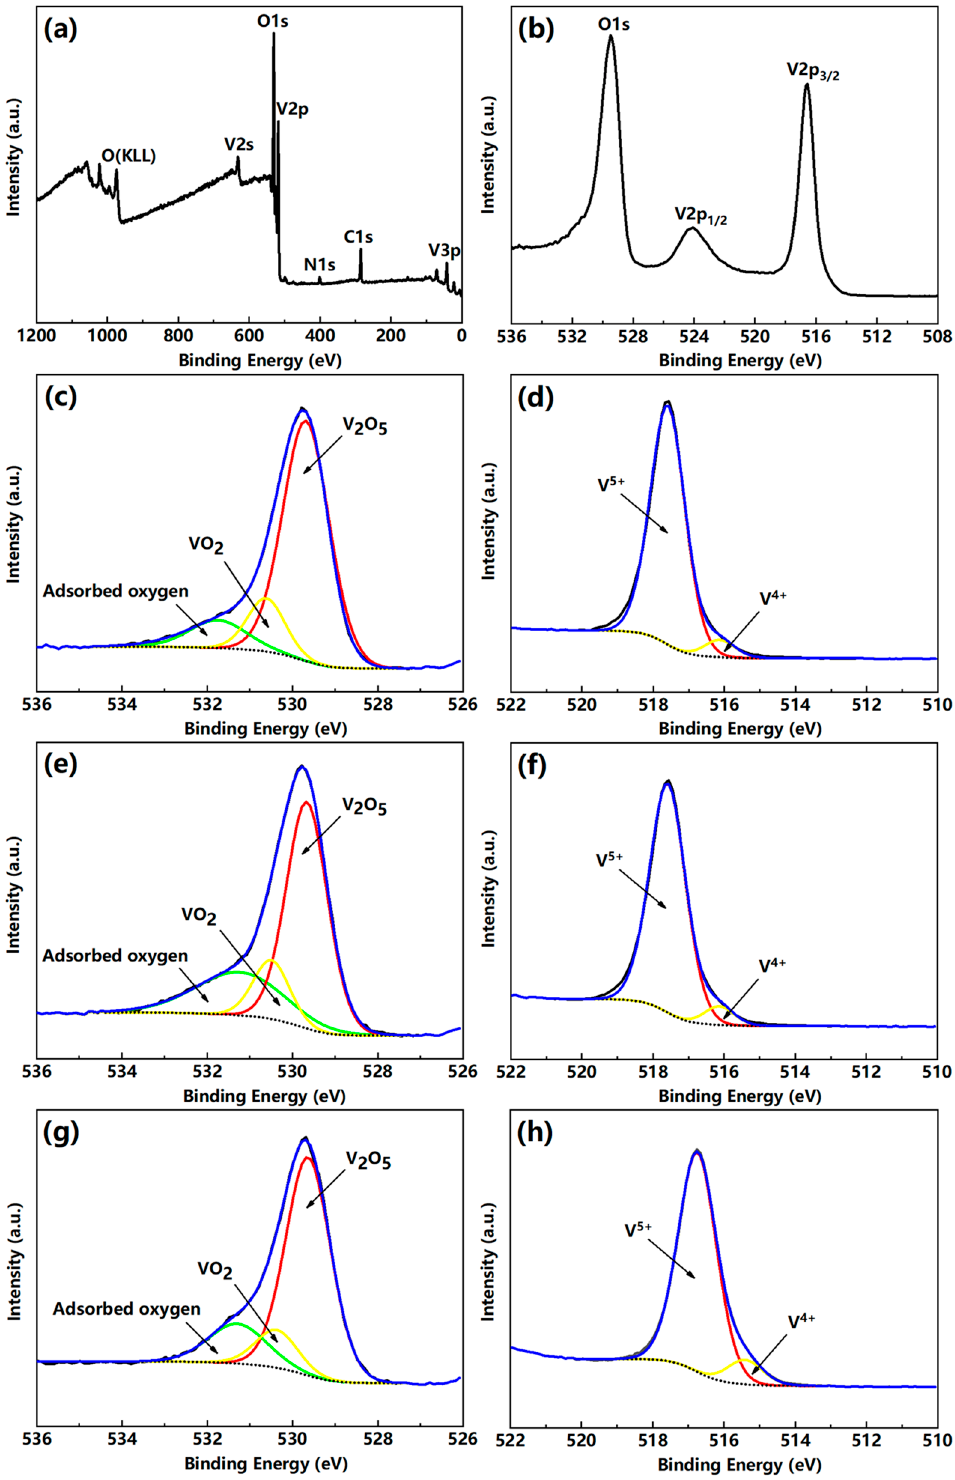
Figure 4. ( a , b ) XPS spectra and high ‐ resolution scan of the V 2 O 5 film on the Al 2 O 3 substrate; ( c , d ) O 1s and V 2p3/2 peaks fitted by Gaussian–Lorentzian curves of the V 2 O 5 /Al 2 O 3 film; ( e , f ) O 1s and V 2p3/2 photoelectron spectra fitting of the V 2 O 5 /MgO film; ( g , h ) O 1s and V 2p3/2 photoelectron spectra fitting of the V 2 O 5 /SiO 2 film.